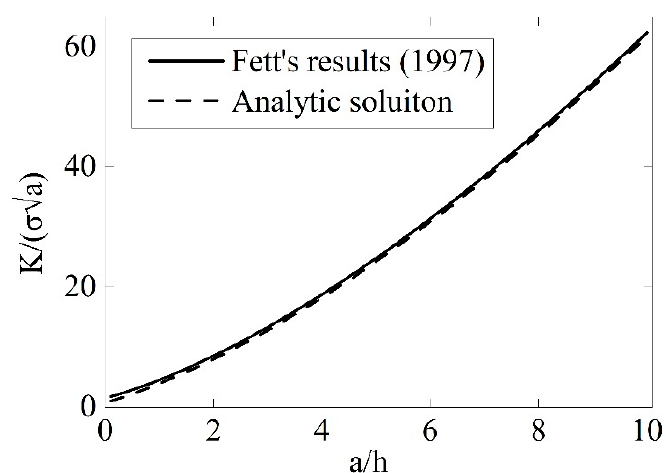
Figure 2. Comparison between stress intensity factor (SIF) between the analytic solution (Equation (9)) using beam theory and the Fett’s result (Equation (12)) using boundary collocation method and the weight functions. for c / h = 3. The two results show good agreement with each other in a wide range. The variables on the horizontal and the vertical coordinates are dimensionless numbers.